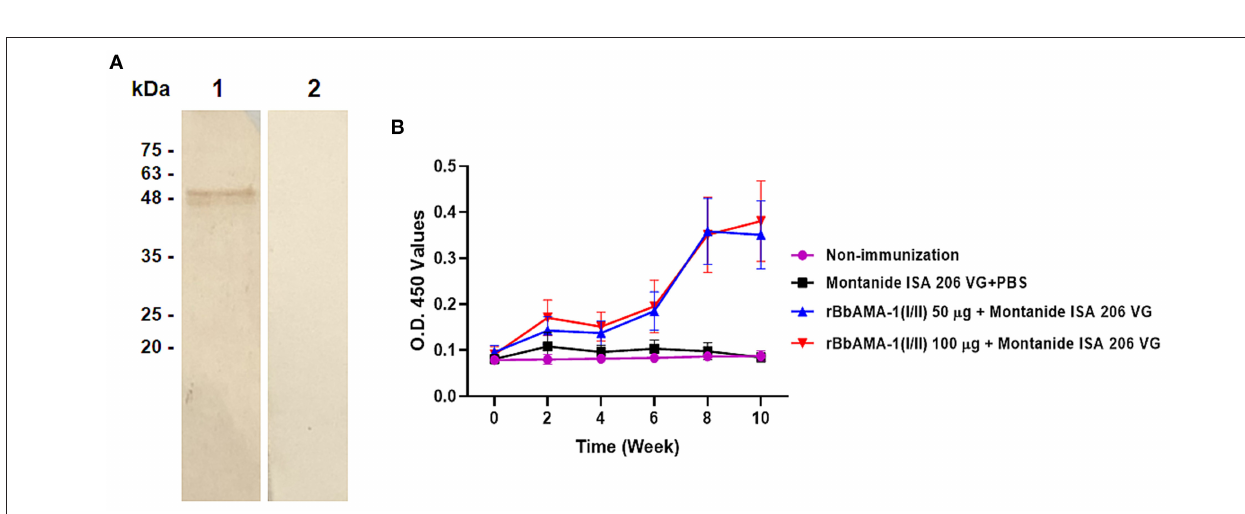
FIGURE 1 | Expression of rBbAMA-1(I/II) analyzed using SDS-PAGE stained with Coomassie brilliant blue (A) and western blotting analysis (B) . Lane 1: Non-induced E. coli strain M15 containing pQE-32/BbAMA-1(I/II) plasmid; Lane 2: Induced E. coli strain M15 containing pQE-32/BbAMA-1(I/II) plasmid; Lane 3: Purified rBbAMA-1(I/II) protein. Black arrows indicate the target protein band of rBAMA-1(I/II).